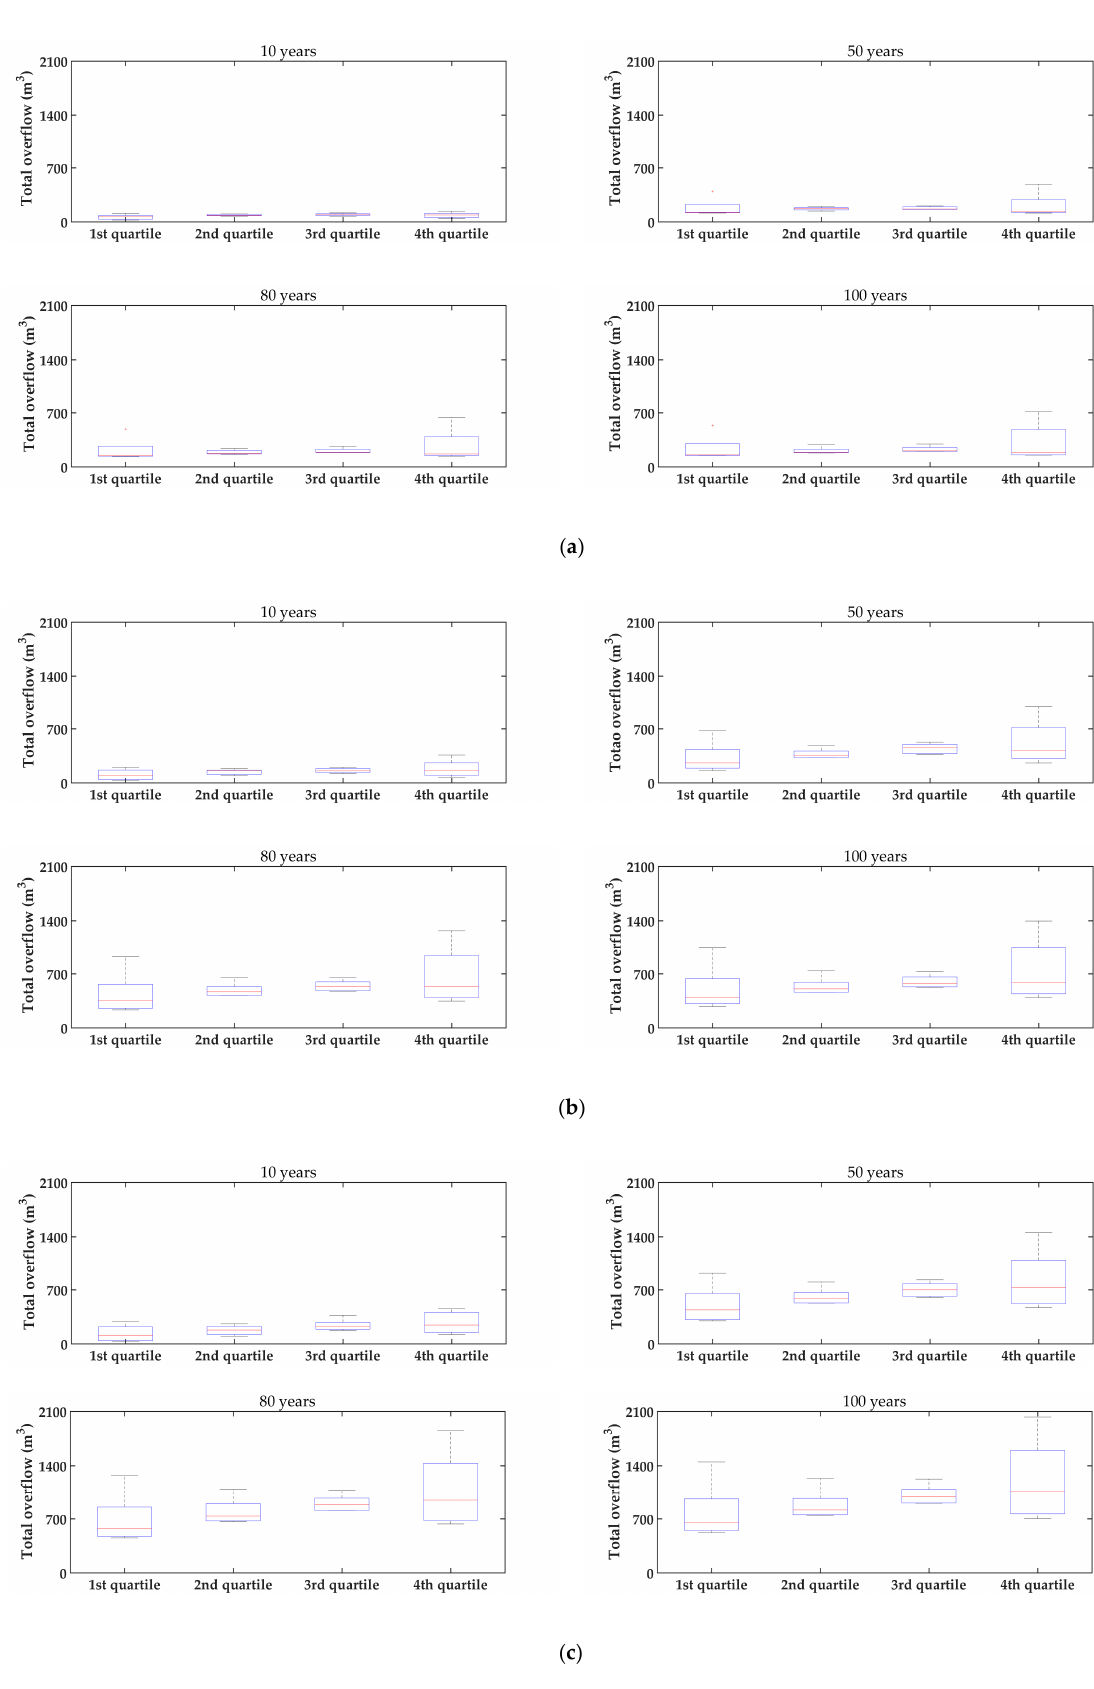
Figure 10. Boxplots of the EPA-SWMM-model-simulated total overflow from 1 to 3 h for a period from 10 to 100 years (( a ) total overflow of 1-h rainfall, ( b ) total overflow of 2-h rainfall, ( c ) total overflow of 3-h